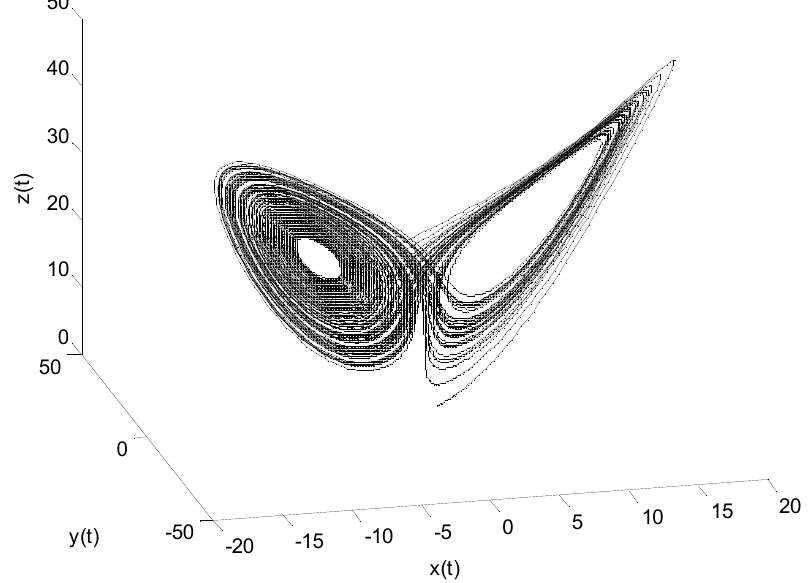
Figure 1. Chaotic attractor of fractional-order Lorenz system